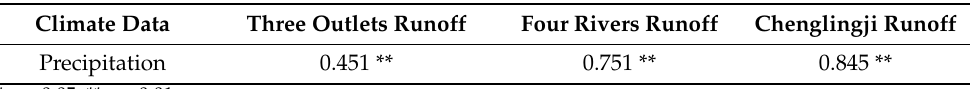
Table 7. Correlation coefficients between different runoffs and